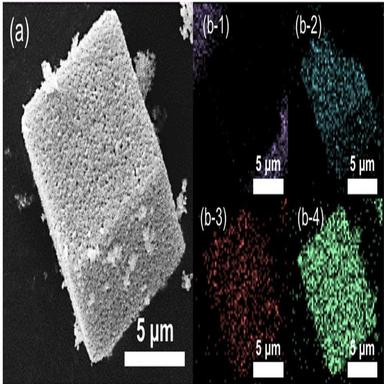
SEM images of (a) CuO/CuCr2O4 composites and their corresponding elemental distribution of (b-1) carbon, (b-2) oxygen, (b-3) chromium, (b-4) copper. Reprinted with permission from Ref. .